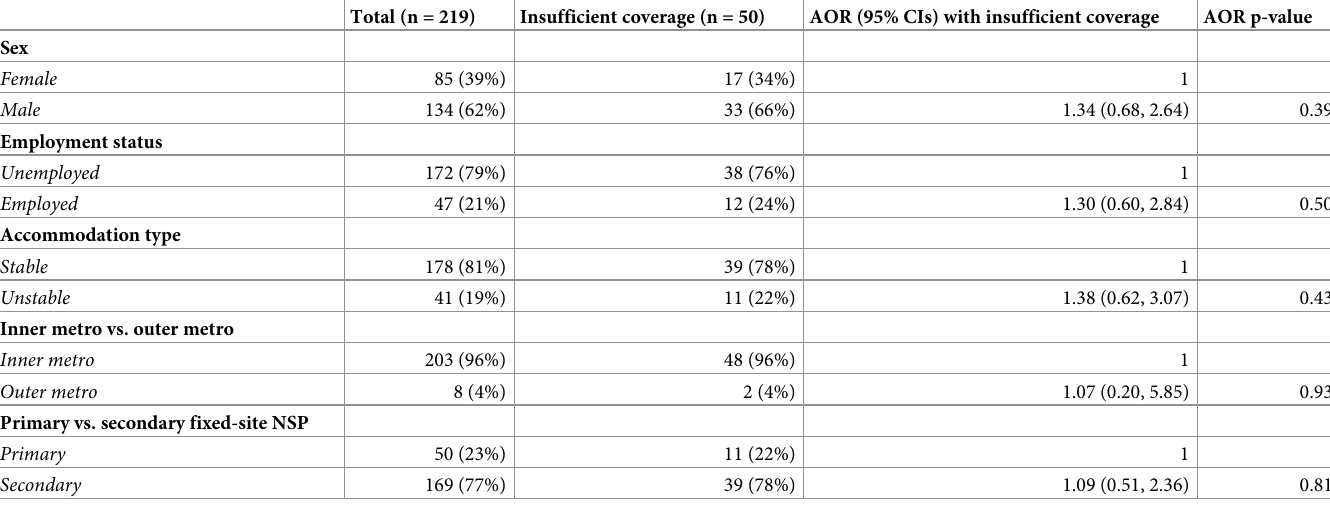
Table 4. Logistic regression associations between independent variables and insufficient coverage amongst PWID in Melbourne, Australia